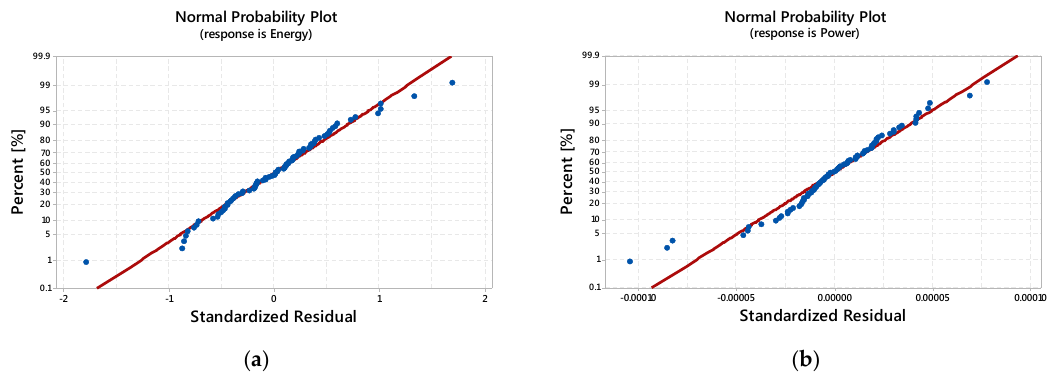
Figure 3. Normal probability plot of standardized residual for: ( a ) the specific energy; ( b ) the specific power.